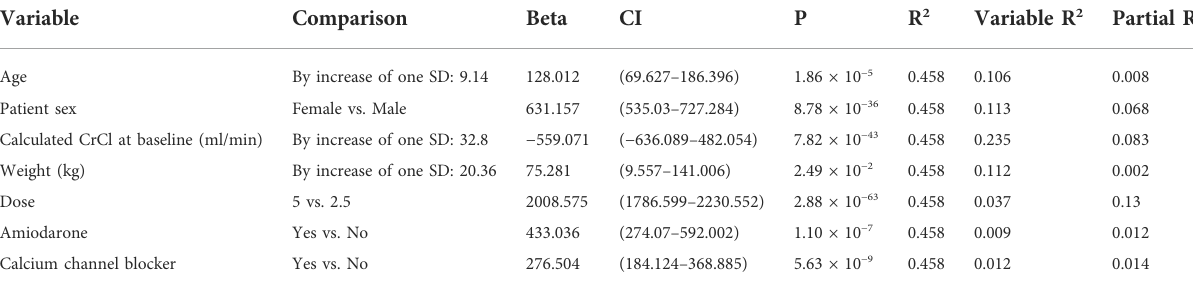
TABLE 3 Area under the curve at steady-state (AUC ss ) — Linear regression results for covariates used in the analyses. N = 1,323 a .